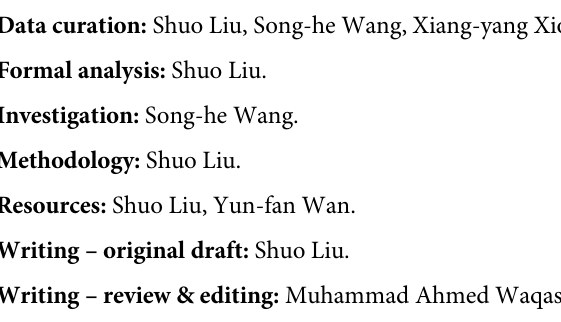
S1 Table. Diurnal variation of temperature (T), relative humidity (RH), and CO2 concen- tration in climatic chambers. Note: (1) SV is set value, MV is monitoring value; (2) The set values of temperature and moisture under CK (400 μmol (cid:1) mol −1 ) treatment are based on the real observation data at Jing Zhou experiment site in 2013; M stands for moderate